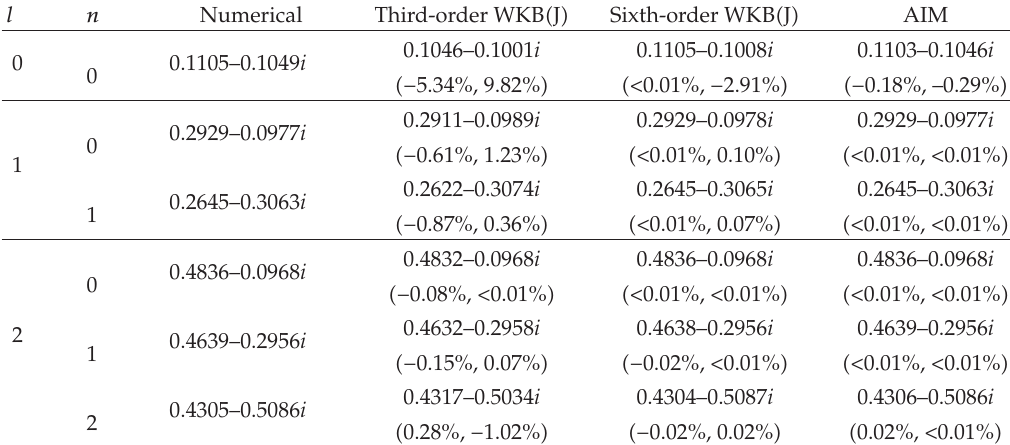
Table 7: The QNM frequencies for the Scalar Perturbations of the Kerr Black Hole, with a (cid:8) 0 . 00, that is, the Schwarzschild limit (cid:2) M (cid:8) 1, m (cid:8) 0 (cid:3) . Numerical data via the CFM were taken from (cid:5) 45, 46 (cid:6) , where the AIM was set to run at 15 iterations.